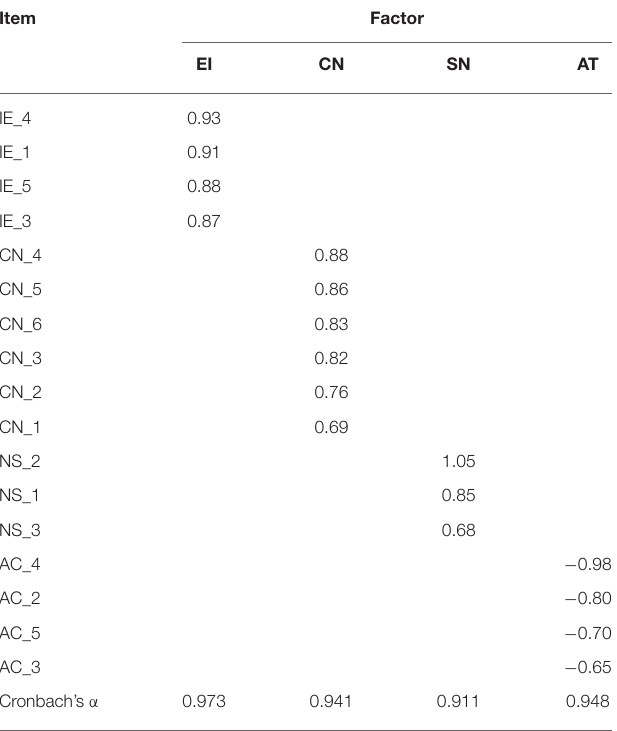
TABLE 4 | Modified rotated factor matrix and reliability